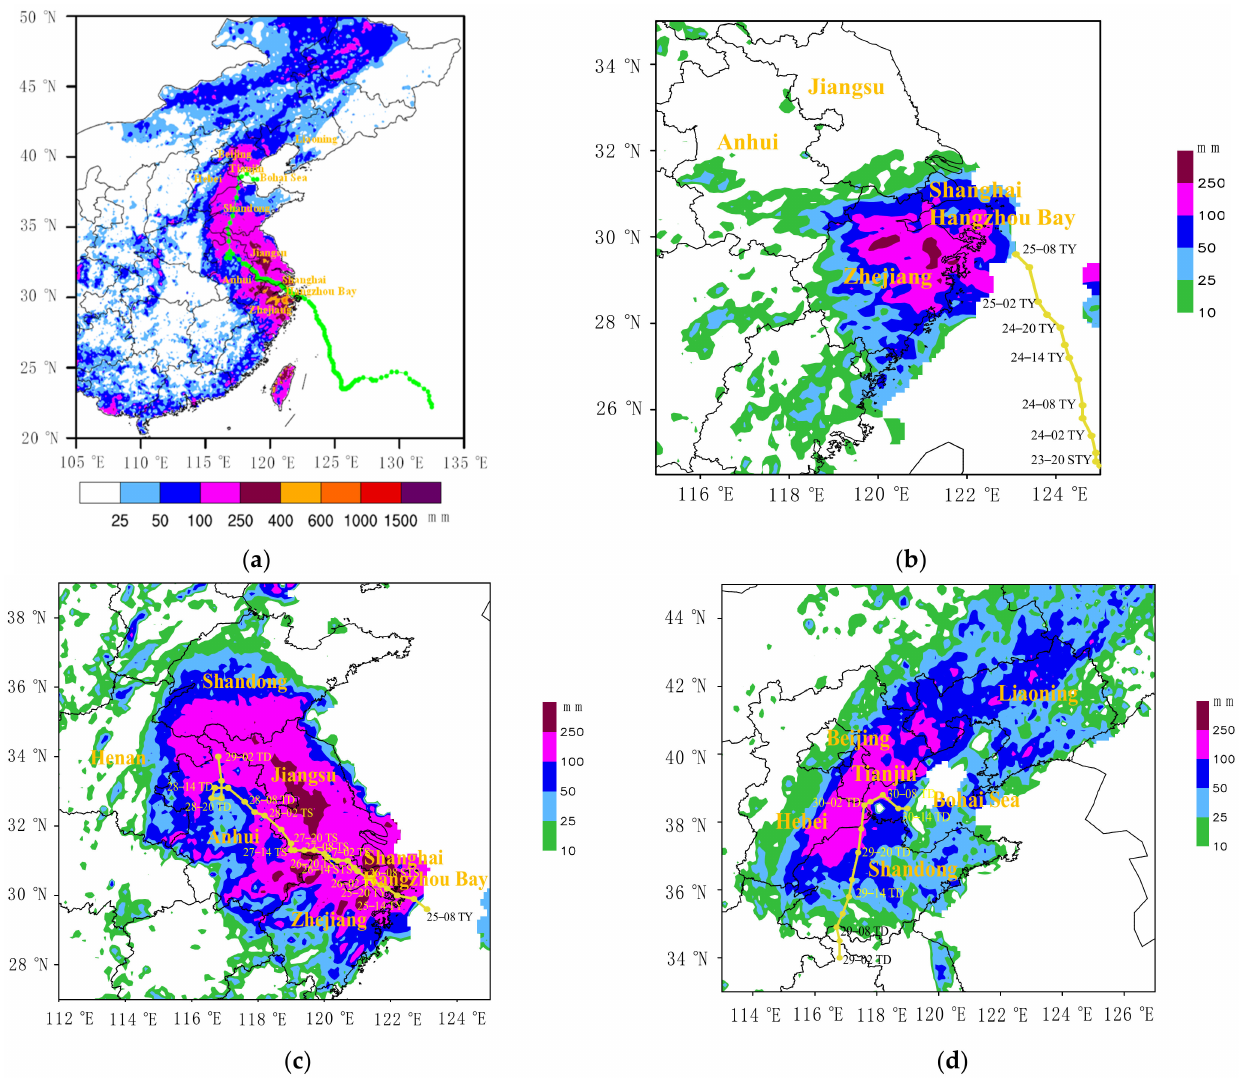
Figure 1. Precipitation distribution of In-Fa. ( a ) Process-accumulated precipitation from 0800 BT on 22 July 2021, to 0800 BT on 1 August 2021, ( b ) 0800 BT on 22 July 2021, to 0800 BT on 25 July 2021, ( c ) 0800 BT on 25 July 2021, to 0200 BT on 29 July 2021, and ( d ) 0200 BT on 29 July 2021, to 0800 BT on 1 August 2021. (The TC track is shown by the dotted lines, and the yellow or black letters show the time (day–hour) and intensity of the TC as follows: TY (typhoon), maximum wind speed (MWS) 32.7–41.4 m s − 1 ; STS (severe tropical storm), MWS 24.5–32.6 m s − 1 ; TS (tropical storm), MWS 17.2–24.4 m s − 1 ; TD (tropical depression), MWS 10.8–17.1 m s − 1